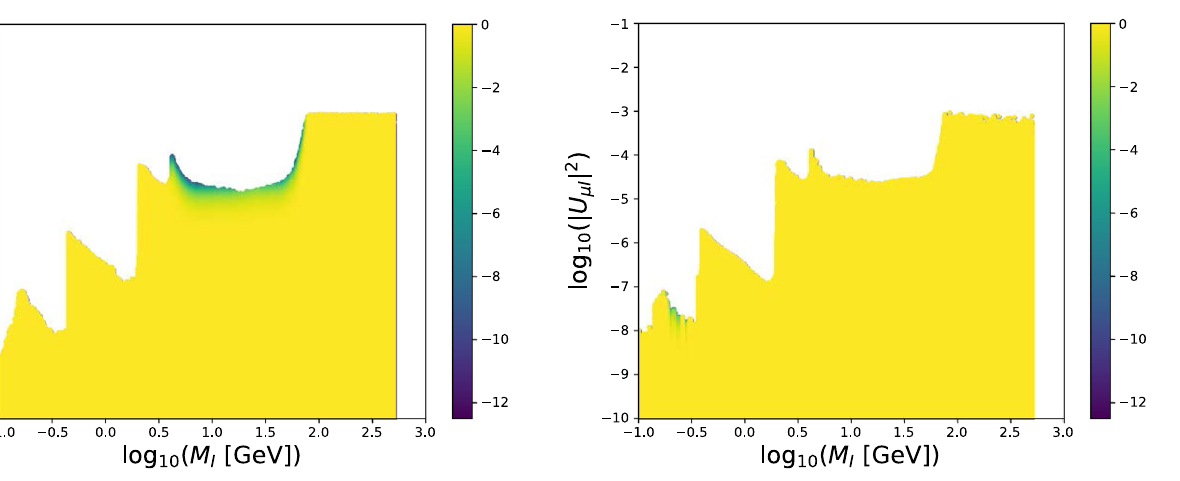
Fig. 25 Partial likelihood from direct searches with E949, μ -channel,